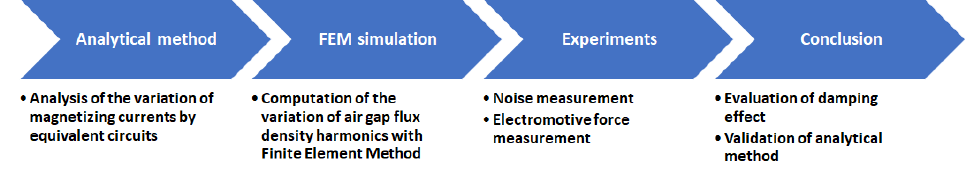
Figure 6. Flowchart of the research